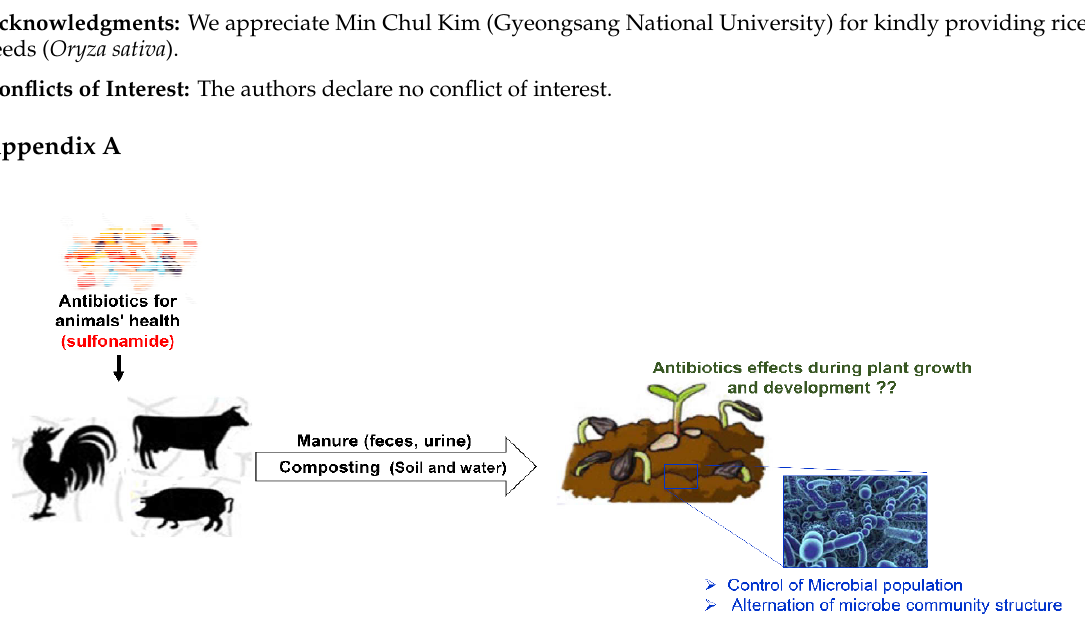
Figure A1. The flow of sulfonamides into the soil environment. Veterinary antibiotics, including sulfonamides, are antimicrobial agents used for animal health and production. Most veterinary antibiotics are excreted with manure due to poor absorption in animal intestines and are released into the soil environment. Contaminated soils a ff ect microbial growth and community structure (depending on antibiotic-resistant traits) and may a ff ect plant growth and development.